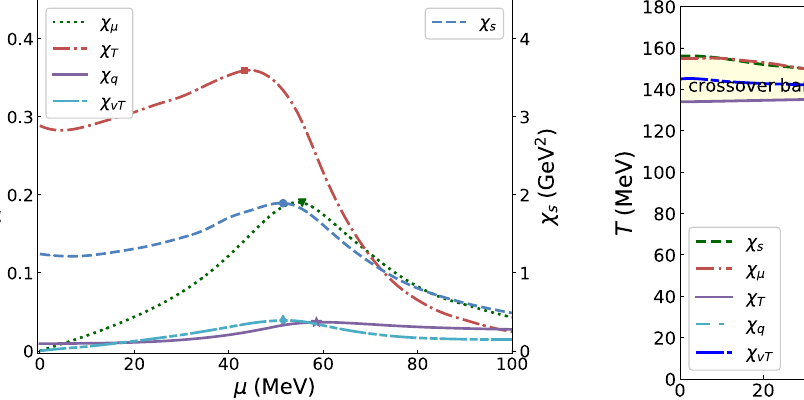
Fig. 4 Five different susceptibilities at T = 145 MeV. χ s is plotted withrightverticalaxis,and χ μ , χ T , χ q , χ v T areplottedwithleftvertical axis